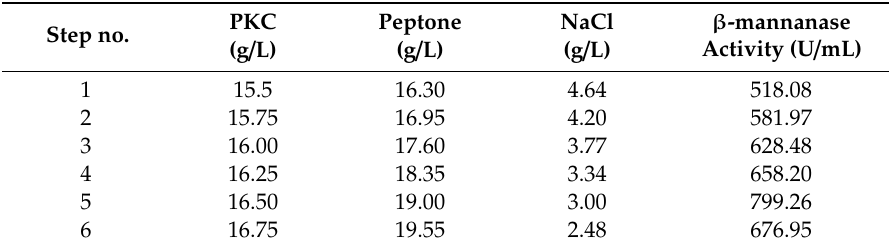
Table 4. Path of steepest ascent for three variables for improvement of β -mannanase production by B. subtilis ATCC 11,774.